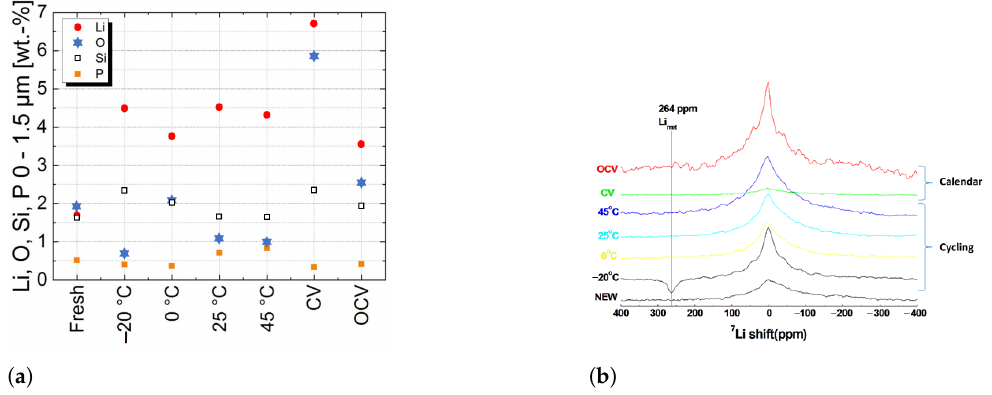
Figure 4. GD-OES and Li-NMR measurements. ( a) Elementary composition of negative elec- trode surface by GD-OES analyses after ageing. ( b ) Li-NMR measurements of negative electrodes after ageing.